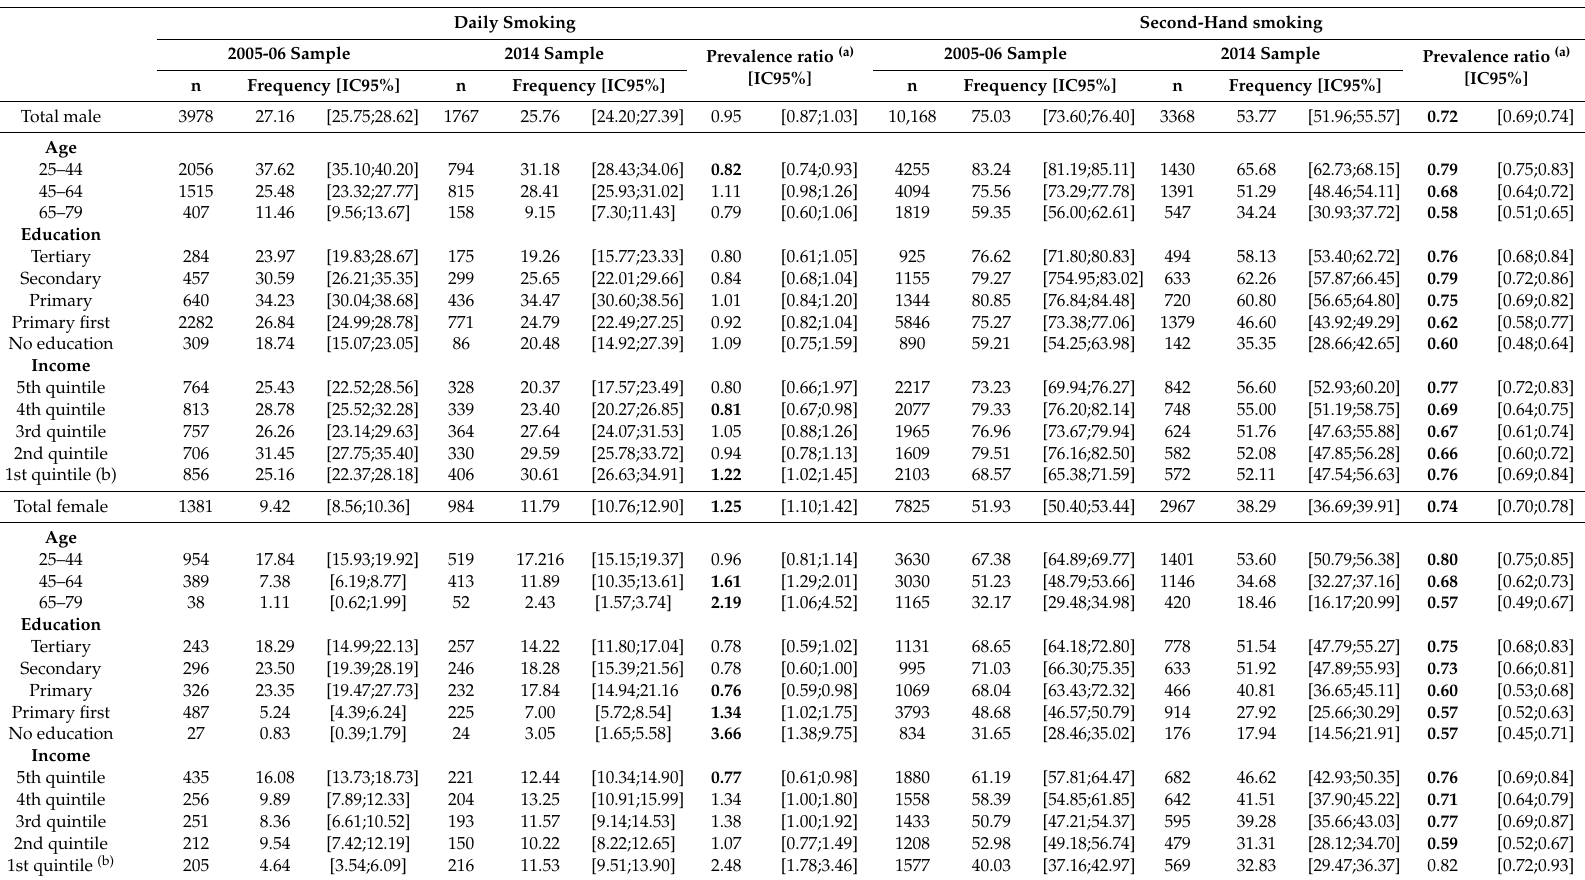
Table 2. Prevalence of smoking and SHS by sex, age, education, and